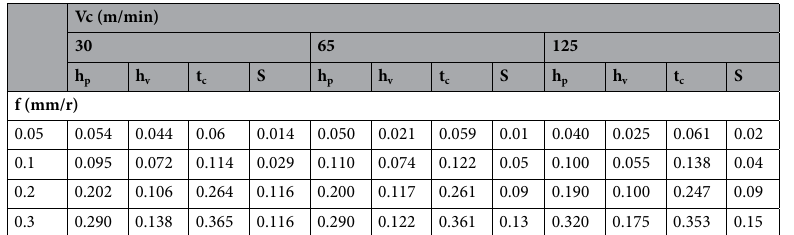
Table 11. Chip geometrical average data, being hp the heights of peaks, hv the heights of valleys, tc the equivalent chip thickness and S the segment width in